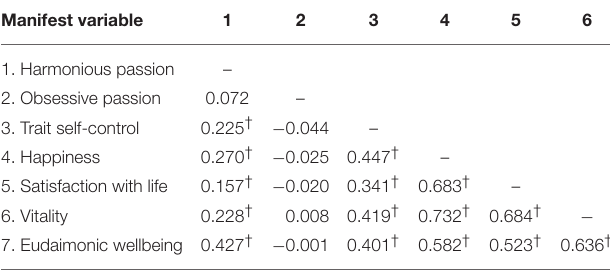
TABLE 3 | Non-parametric (Spearman’s rho) correlations for all manifest variables. Manifest